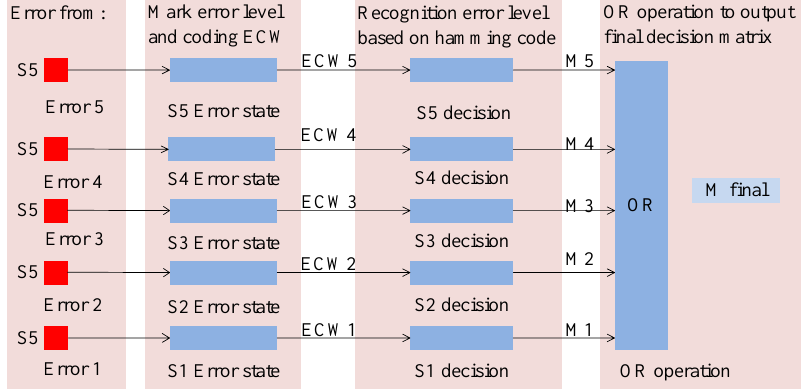
Figure 5. Decision model with three detection channels driven by error data. ECW—error correction word.